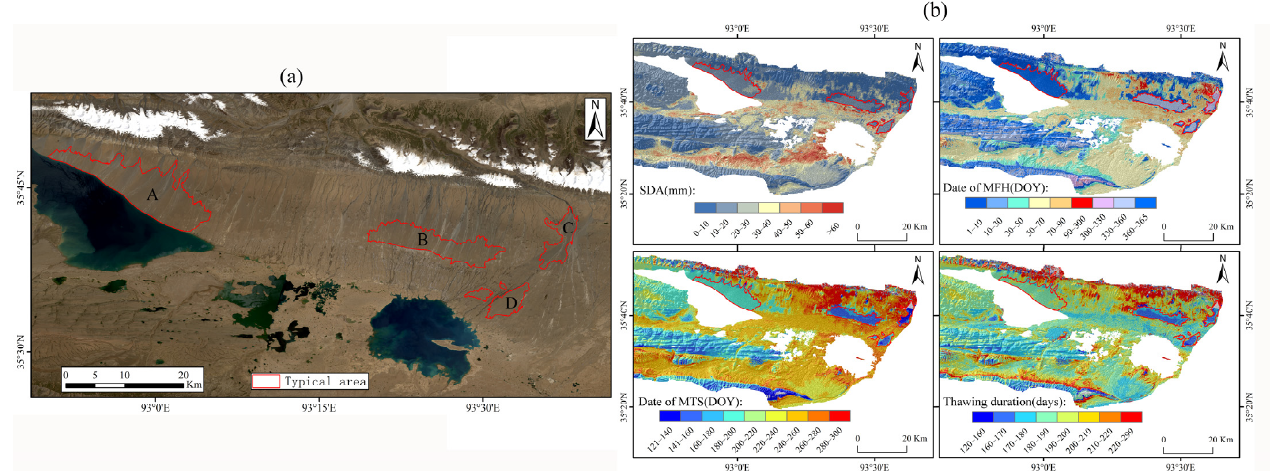
Figure 11. Seasonal deformation characteristics of the regions of interest and their surroundings (delineated with red lines). ( a ) The regions of interest (delineated with red lines), and the background is the Landsat-8 natural actual color image. ( b ) The SDA, the date of MFH, the date of MTS, and thawing duration in the north of Kusai lake and Yanhu lake.